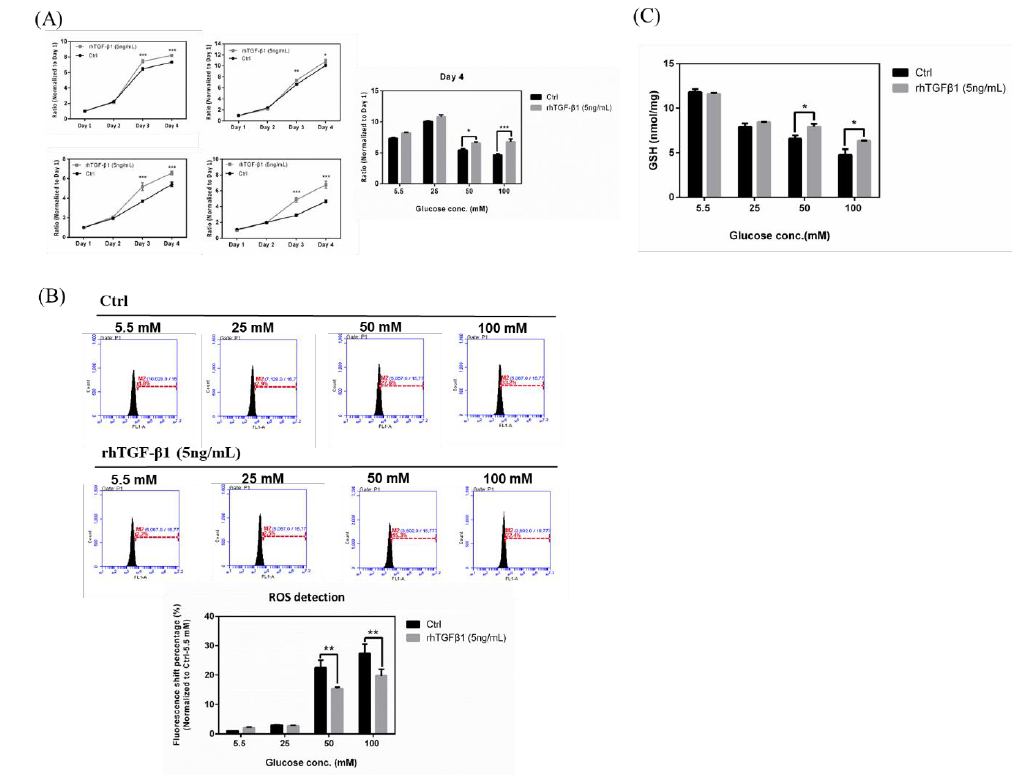
Figure 6. E ff ects in RGCs with hyperglycemia with or without ( w / o ) recombinant TGF- β 1 protein (5 ng / mL). ( A ) Left: Cell proliferation rates under di ff erent glucose concentrations were examined from Day 1 to Day 4 using the cell viability assay. The data from Day 2, Day 3, and Day 4 were normalized to Day 1. RGC-5 cells were incubated in 5.5 mM, 25 mM, 50 mM, and 100 mM glucose for long-term exposure and plated into 96-well plates to observe the proliferation rate with or w / o recombinant TGF- β 1 protein (5 ng / mL) in di ff erent glucose concentrations. Right: Isolated Day 4 data show the di ff erential proliferation rate in RGC-5 cells with recombinant TGF- β 1 protein in four glucose concentrations. Data are represented as mean ± SEM. *, p < 0.05; and ***, p < 0.001 when compared to Ctrl. ( B ) Upper: iROS accumulation e ff ects in RGCs with hyperglycemia with or w / o recombinant TGF- β 1 protein (5 ng / mL). Intracellular ROS content were evaluated by the APF staining method on RGC-5 cell cultures following 3 weeks at di ff erent glucose concentrations (5.5 mM, 25 mM, 50 mM, and 100 mM glucose) with or w / o recombinant TGF- β 1 protein (5 ng / mL). After exposure, 106 cells were incubated with APF at a specific concentration (5 µ M) in PBS. Intracellular ROS generation was quantified by flow cytometry. ( n = 3) Lower: Relative fluorescence shift percentage was quantified and normalized with respect to the Ctrl (5.5 mM). Data derived from three independent experiments are presented as mean ± SEM. **, p < 0.01 when compared to Ctrl. ( C ) GSH content in RGCs with hyperglycemia with or w / o recombinant TGF- β 1 protein (5 ng / mL). Dose responses involving total GSH contents in RGC-5 cells treated with 5.5 mM, 25 mM, 50 mM and 100 mM glucose concentration medium with or w / o recombinant TGF- β 1 protein were assayed. Data are represented as means ± SEM. *, p < 0.05 when compared to the Ctrl.